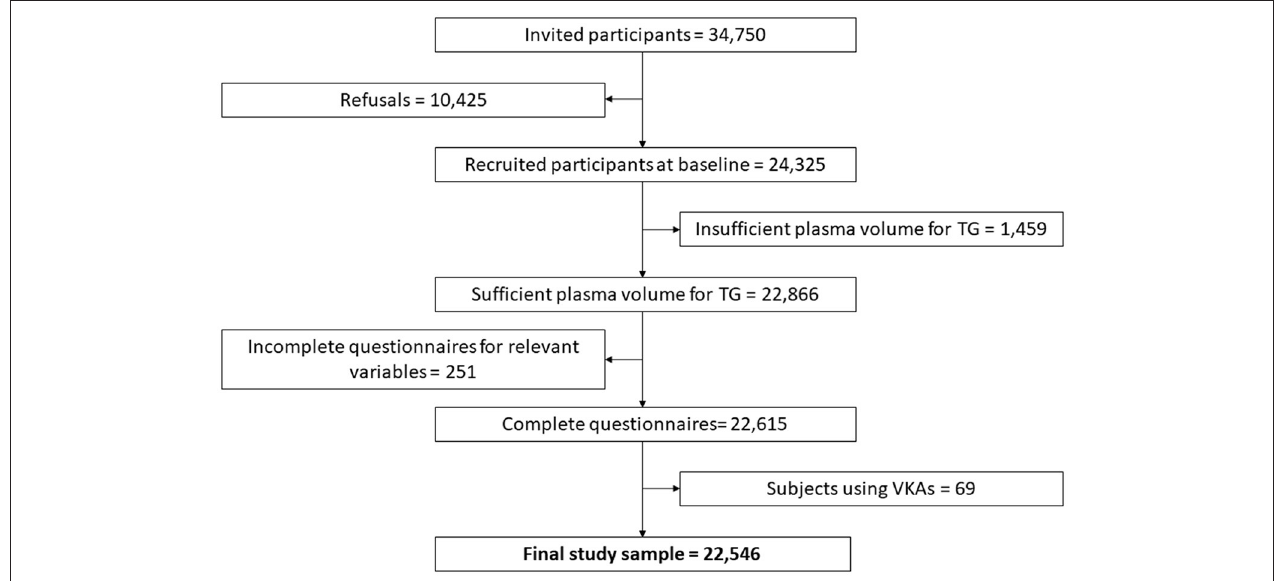
FIGURE 1 | Flowchart of selection of the studied population among Moli-sani participants. The groups of eliminated participants (of the 24 325 recruited at baseline) overlap and the scheme shows sequential exclusion criteria. Therefore, the patients in each eliminated group do not fulfill the previous elimination criteria, but it is possible that patients on VKAs were previously eliminated because of e.g., insufficient plasma volume for thrombin generation.